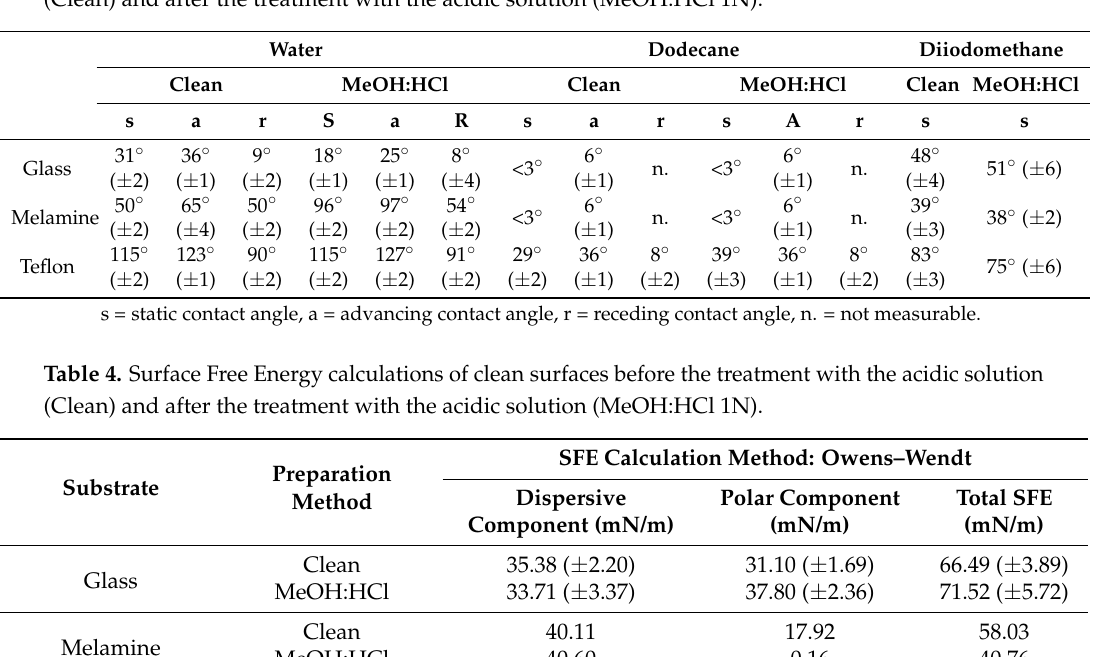
Table 3. Contact angle measurements of clean surfaces before the treatment with the acidic solution (Clean) and after the treatment with the acidic solution (MeOH:HCl 1N).